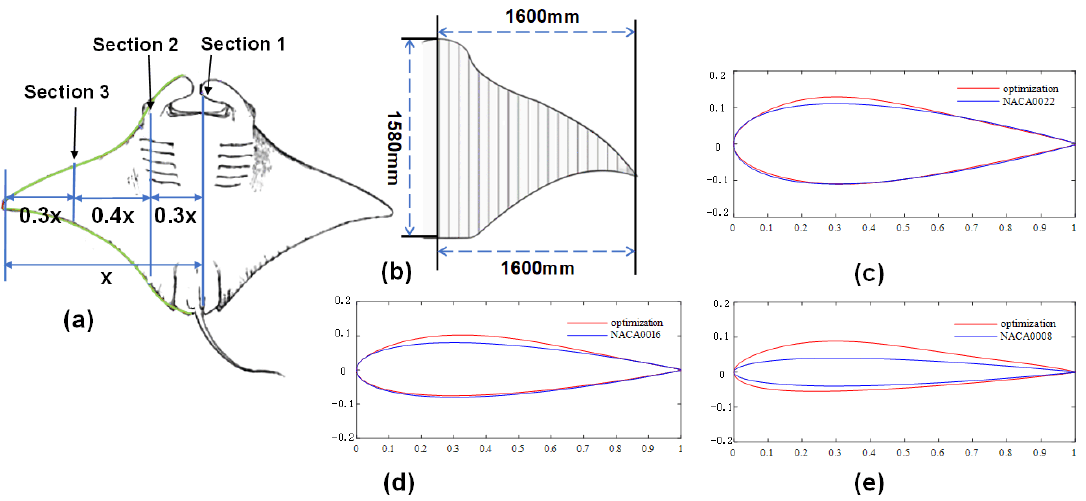
Figure 1. The shape design of the manta ray robot. ( a ) The schematic diagram of a real manta ray; ( b ) the scale of the robot; ( c ) the NACA0022 and optimized airfoils; ( d ) the NACA0016 and optimized airfoils; ( e ) the NACA0008 and optimized airfoils.